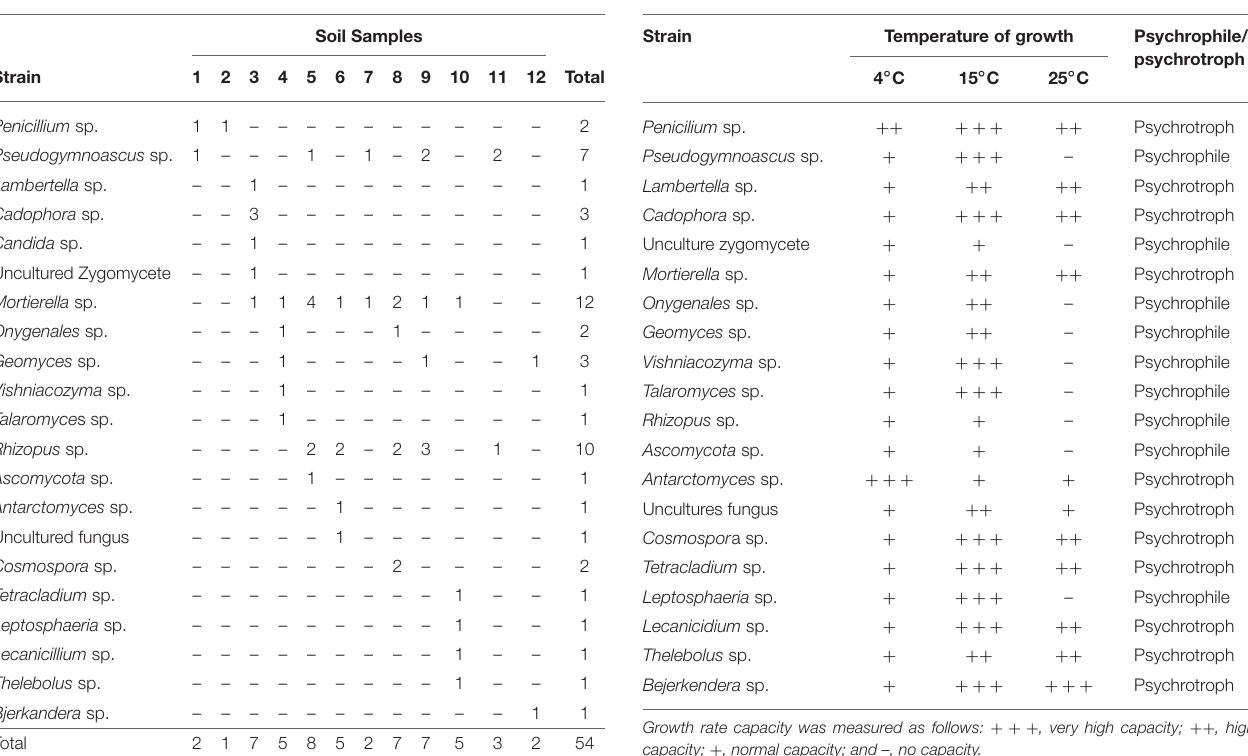
TABLE 3 | Presence of culturable fungal strains in each soil samples. TABLE 4 | Fungal growth at different